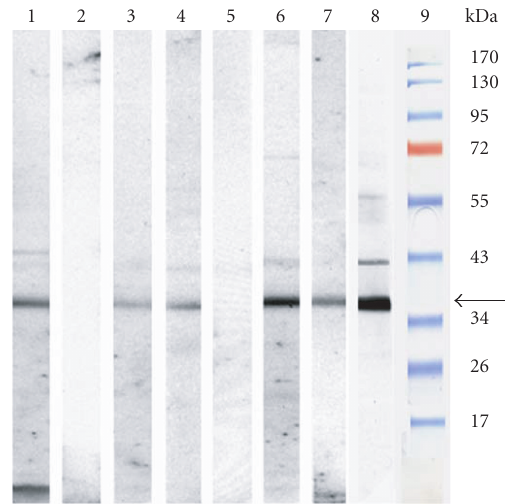
Figure 2: Representative Western blot signals at 36 kD obtained against purified human CRALBP. Sera of human uveitis patients and healthy controls were tested on 1D Western blots. Lane 1: strong sig- nal of healthy control, lane 2: healthy signal of healthy control, lanes 3 and 4: intermediate signal of uveitis patients, lane 5: healthy signal of uveitis patient, lane 6 and 7: strong signal of uveitis patients, lane 8: monoclonal anti-human recombinant CRALBP antibody (Cay- man), lane 9: marker with respective molecular weights.